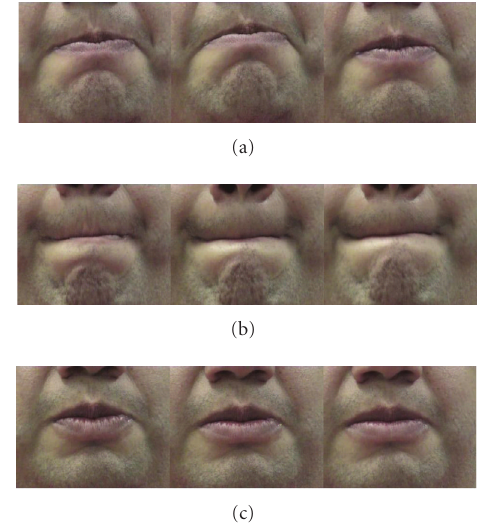
Figure 3: Visual di ff erences in the pronunciation of the phoneme m in the word “ama”: (a) normal pronunciation; (b) with emphasis; (c) mumbling. In each case, Person B pronounced the word 3 times to show potential variation.